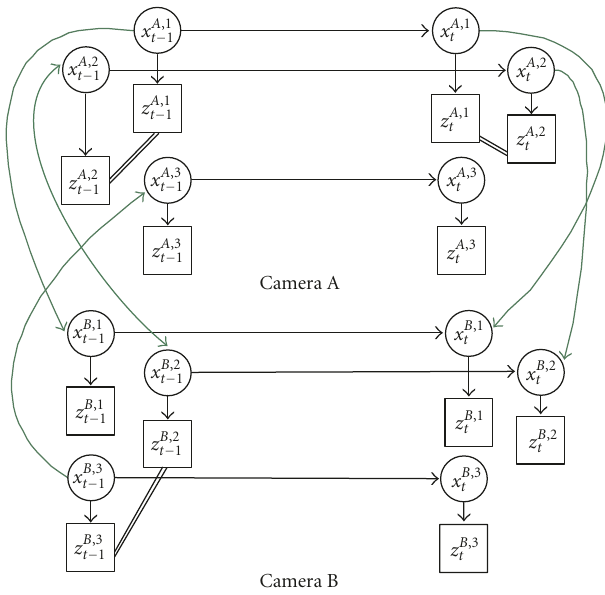
Figure 1: The dynamic graphical model for multiple-target tracking using multiple collaborative cameras. The directed curve link shows the “camera collaboration” between the counterpart states in di ff erent